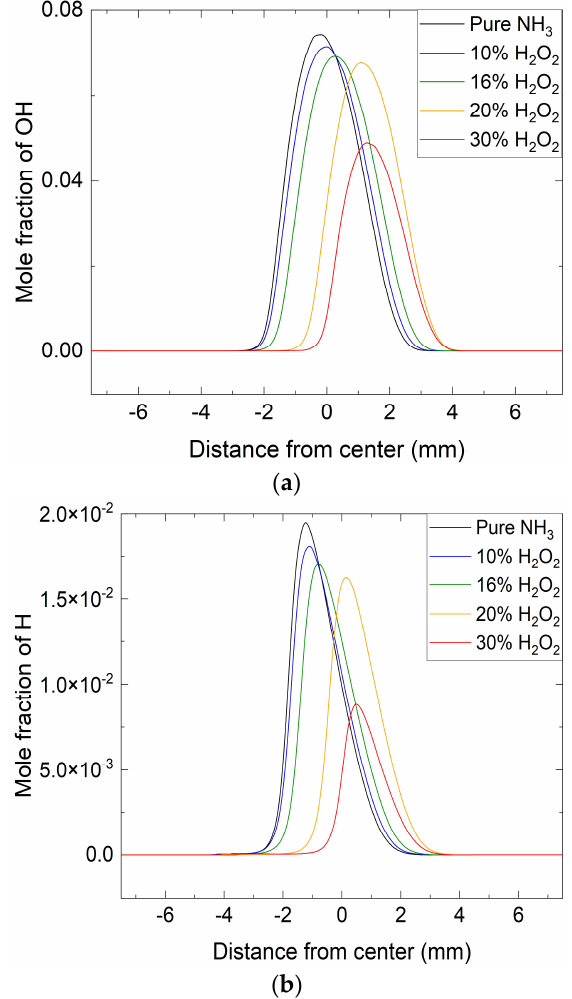
Figure 9. OH ( a ) and H ( b ) mole fraction distributions along the burner center line.